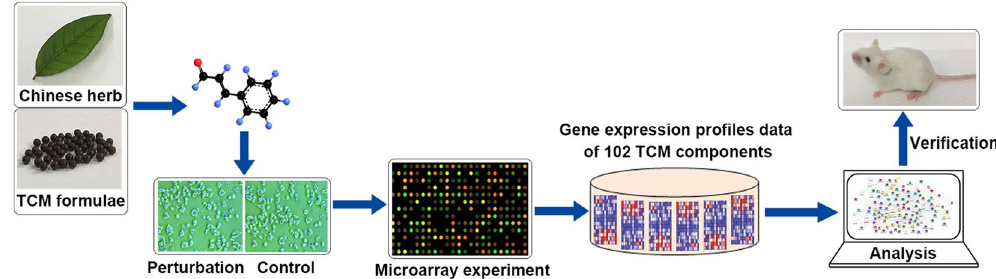
Figure 1. The schematic view of data construction and